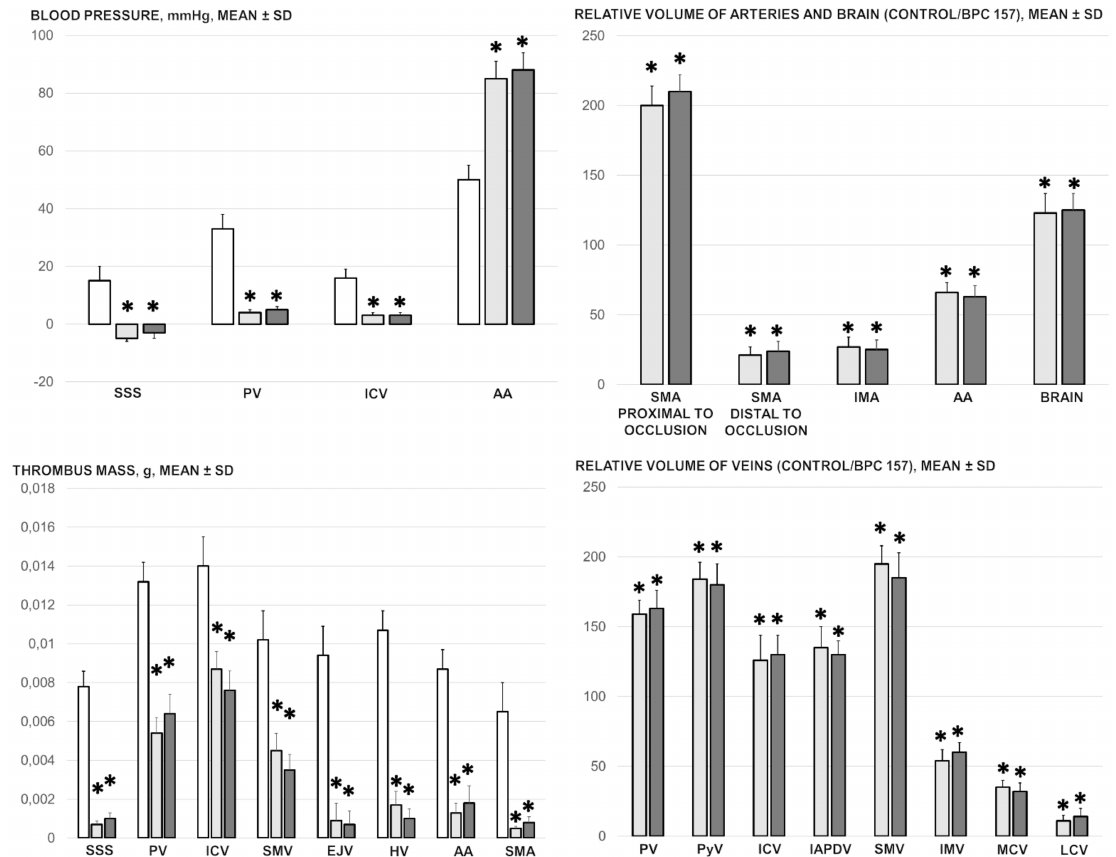
Figure 1. Blood pressure, mm Hg (in the superior sagittal sinus (SSS), portal vein (PV), abdominal aorta (AA), inferior caval vein (ICV)), thrombus mass, g (in the superior sagittal sinus (SSS), portal vein (PV), inferior caval vein (ICV), superior mesenteric vein (SMV), external jugular vein (EJV), hepatic veins (HV), abdominal aorta (AA) and superior mesenteric artery (SMA)), relative volume of arteries (superior mesenteric artery (SMA), proximal to occlusion and distal to occlusion, inferior mesenteric artery (IMA), abdominal aorta (AA) and brain) and relative volume of veins (portal vein (PV), pyloric vein (PyV), inferior caval vein (ICV), inferior anterior pancreaticoduodenal vein (IAPDV), superior mesenteric vein (SMV), inferior mesenteric vein (IMV), middle colic vein (MDV) and left colic vein (LCV)) presentation in the rats with ligated superior mesenteric vein and artery at the 30 min ligation-time, following medication (BPC 157 10 µ g/kg (light gray bars), 10 ng/kg (dark gray bars); saline 5 mL/kg (white bars) given intraperitoneally. Especially, as described previously [5–7], pressure recordings were made in deeply anesthetised rats with a cannula (BD Neoflon™ Cannula, Franklin Lakes, NJ, USA) connected to a pressure transducer (78534C MONITOR/TERMINAL; Hewlett Packard, Houston, TX, USA) inserted into the portal vein, inferior caval vein and superior sagittal sinus, and abdominal aorta at the level of the bifurcation at 30 min post-ligation after 5 min of recording (see, Section 2.5). Six rats/group/interval. Mean ± SD, * p < 0.05, at least vs.